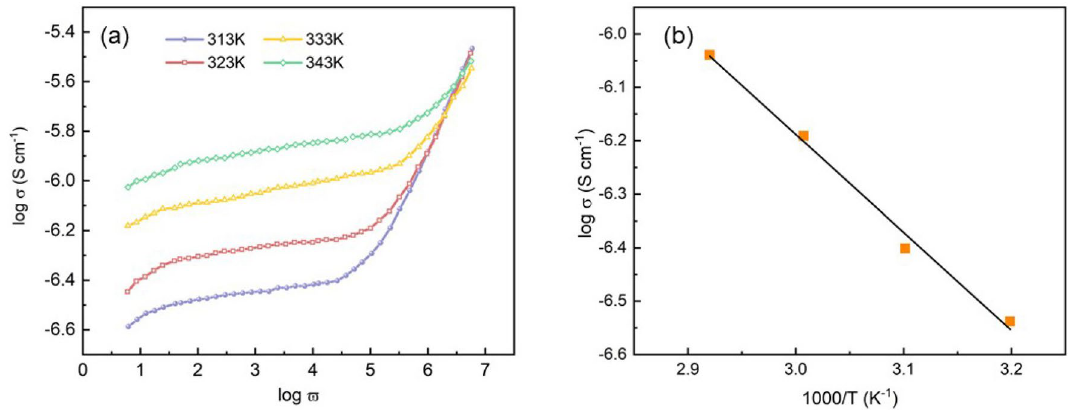
Figure 2. ( a ) Frequency dependent conductivity of the solid electrolyte, ( b ) log σ versus 1000/T plot of the electrolyte. The solid line indicates the linear